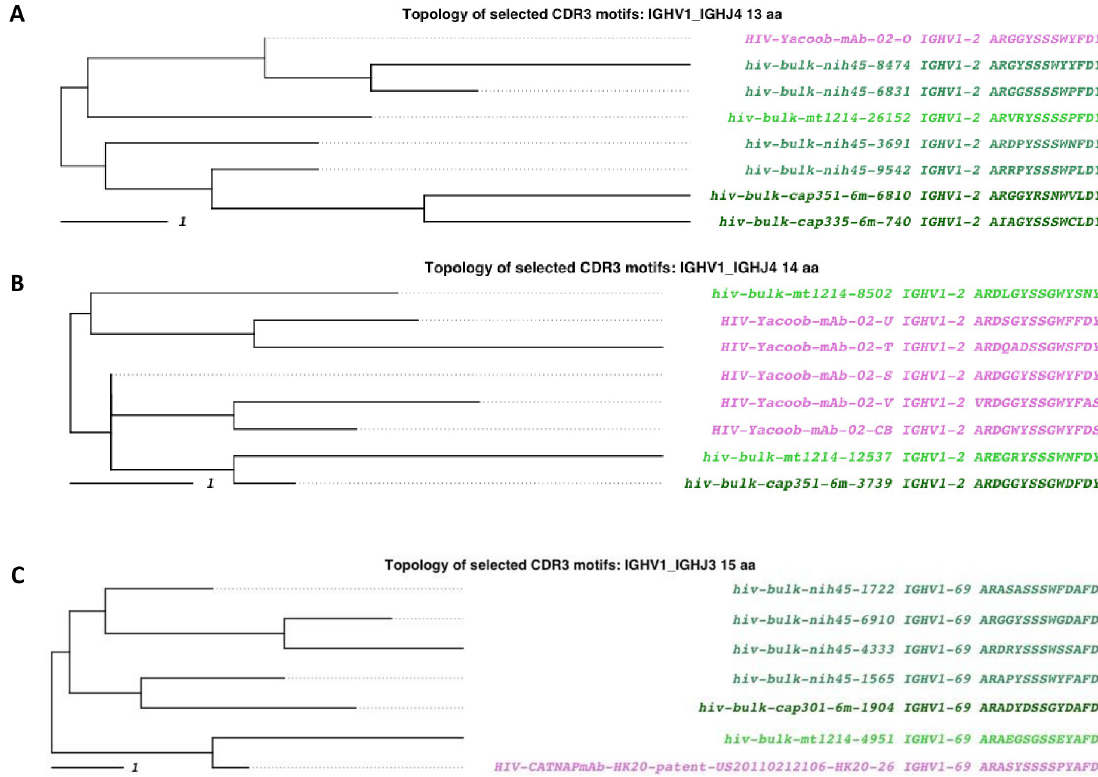
Fig 6. HIV-1 convergent clonotypes to antibodies from Setliff et al. (2018; Fig 4). (A) Convergent clonotypes to mAb 02-o in the 1_4_13 bin. (B) Convergent clonotypes to mAb 02-s in the 1_4_14 bin. (C) Convergent clonotypes to mAb HK20 in the 1_3_15 bin. A 70% identity threshold is used to calculate convergence. Tips are colored by dataset source. Purple tips are published anti-COVID-19 antibodies, and green shaded tips are antibody sequences from HIV-1 patient BCR repertoires.